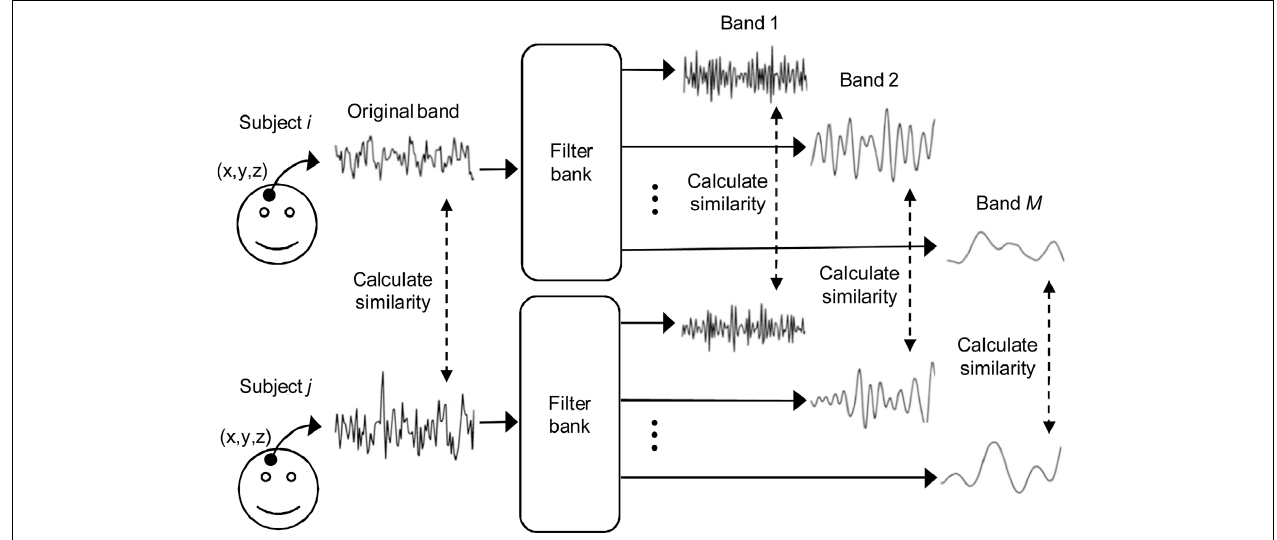
FIGURE 1 | General concept of frequency-specifi c ISC analysis. Voxel-by-voxel ISC is calculated across subjects over the original fMRI time-series as well as over several frequency sub-bands. The method is extended to a multi-subject analysis by combining the results of each subject pair into a single statistic representing an average across-subject